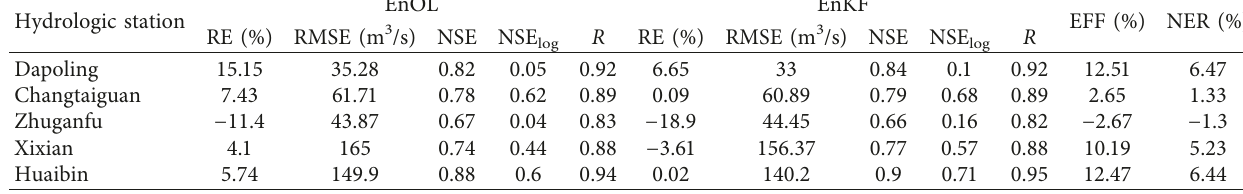
Table 4: Statistical comparison of the estimated streamflow in EnOL and EnKF cases based on the observed streamflow over 2003–2006. Hydrologic